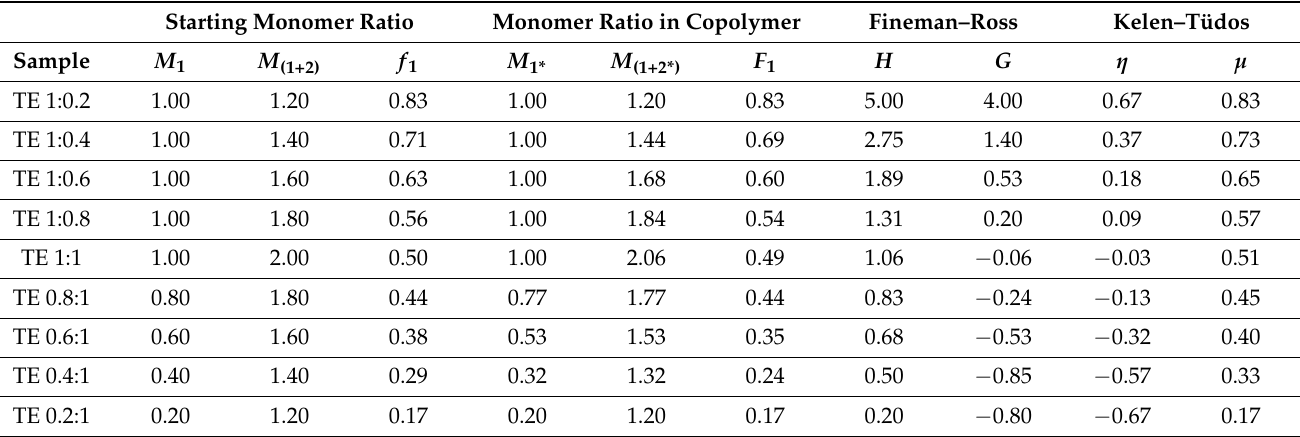
Table 5. Parameters for the statistical copolymers.